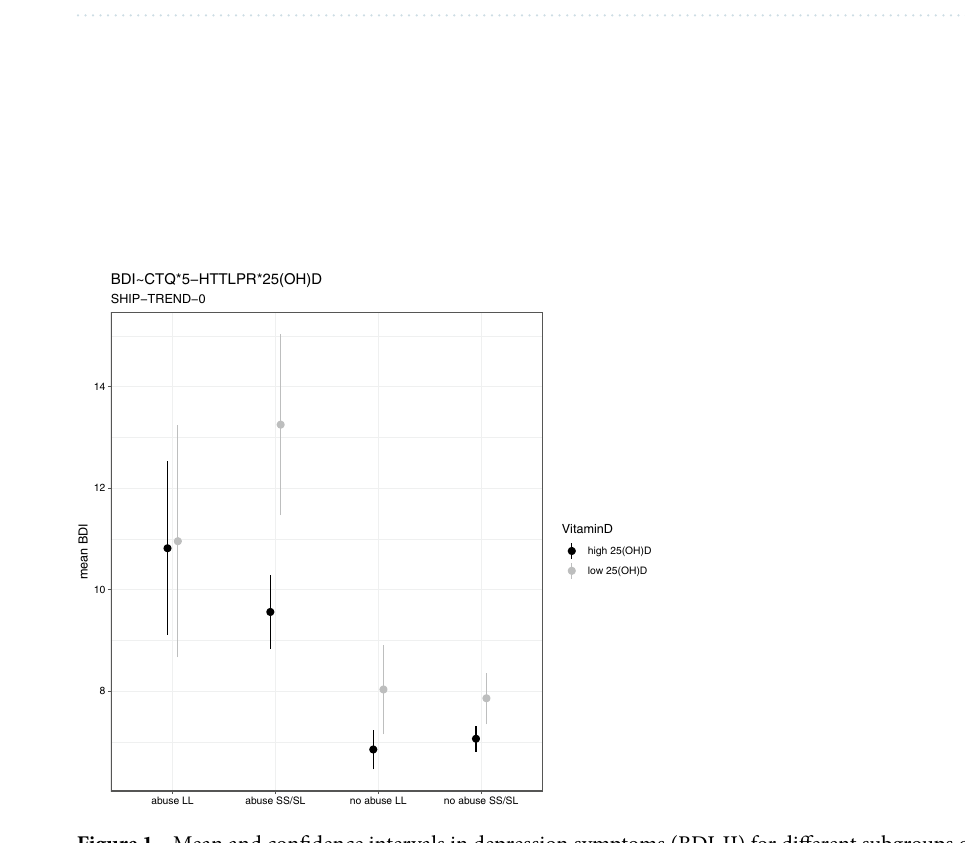
Table 1. Summary statistics of SHIP-LEGEND and SHIP-TREND by sex. NA, not available in the cohort. † None versus at least mild abus, t -test for metric data, χ 2 -test for non-metric data.